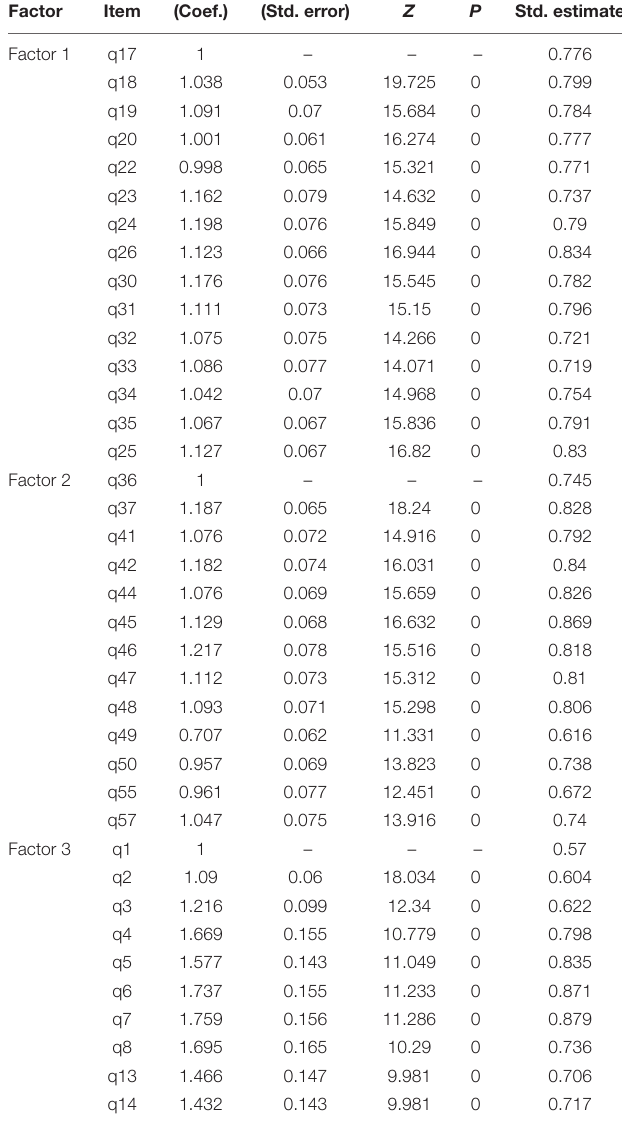
TABLE 3 | Coefficient of factor